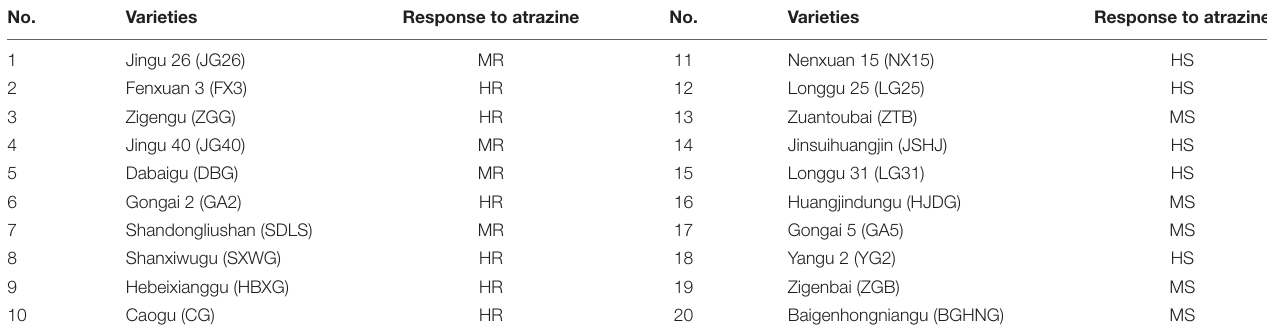
TABLE 1 | Varieties used in the field